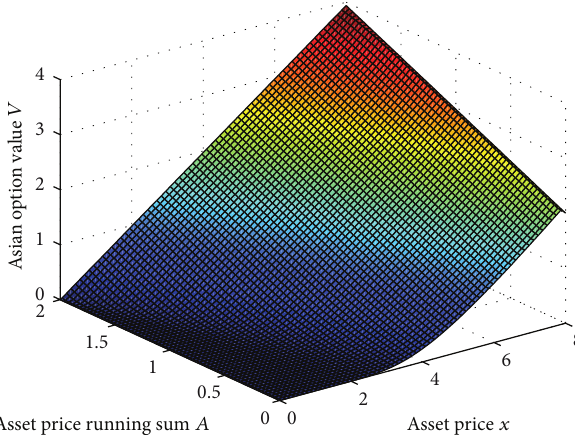
Figure 2: Computed Asian option value 𝑉 for Test